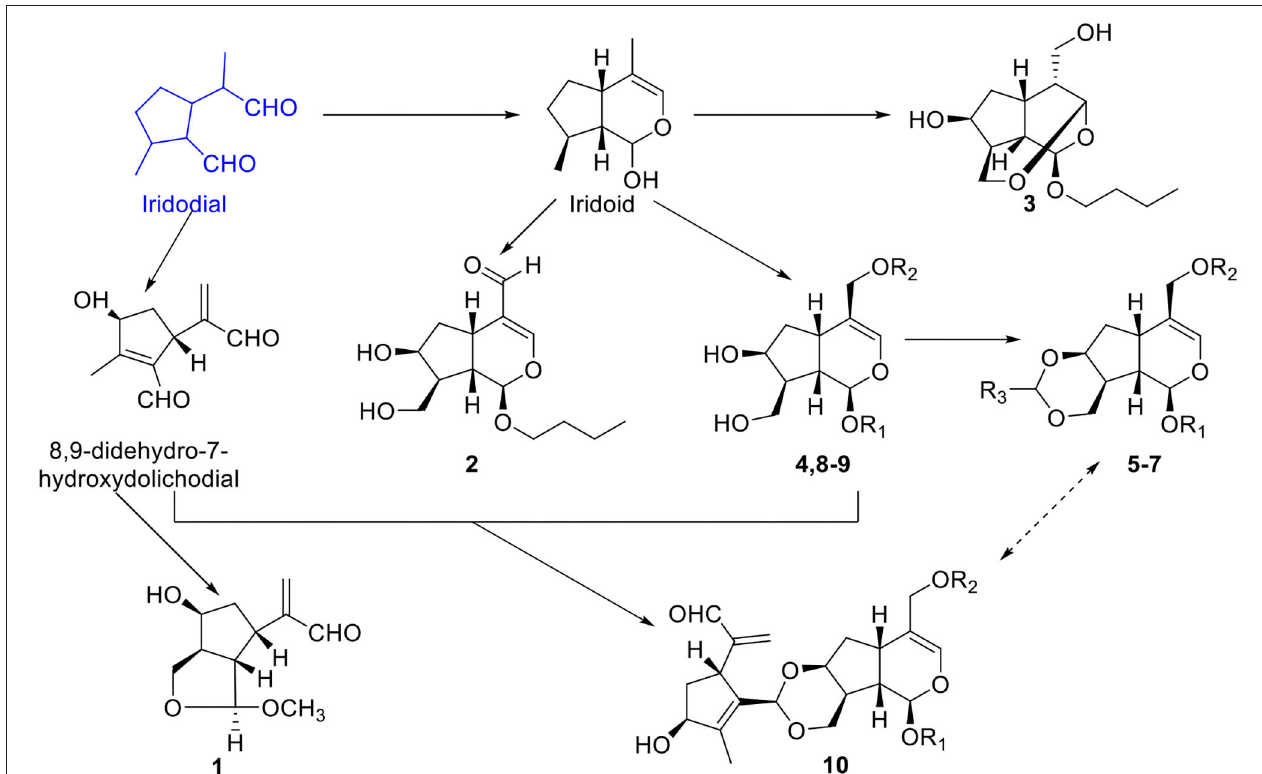
FIGURE 10 | The possible pathway for the transformation of compounds 1 -